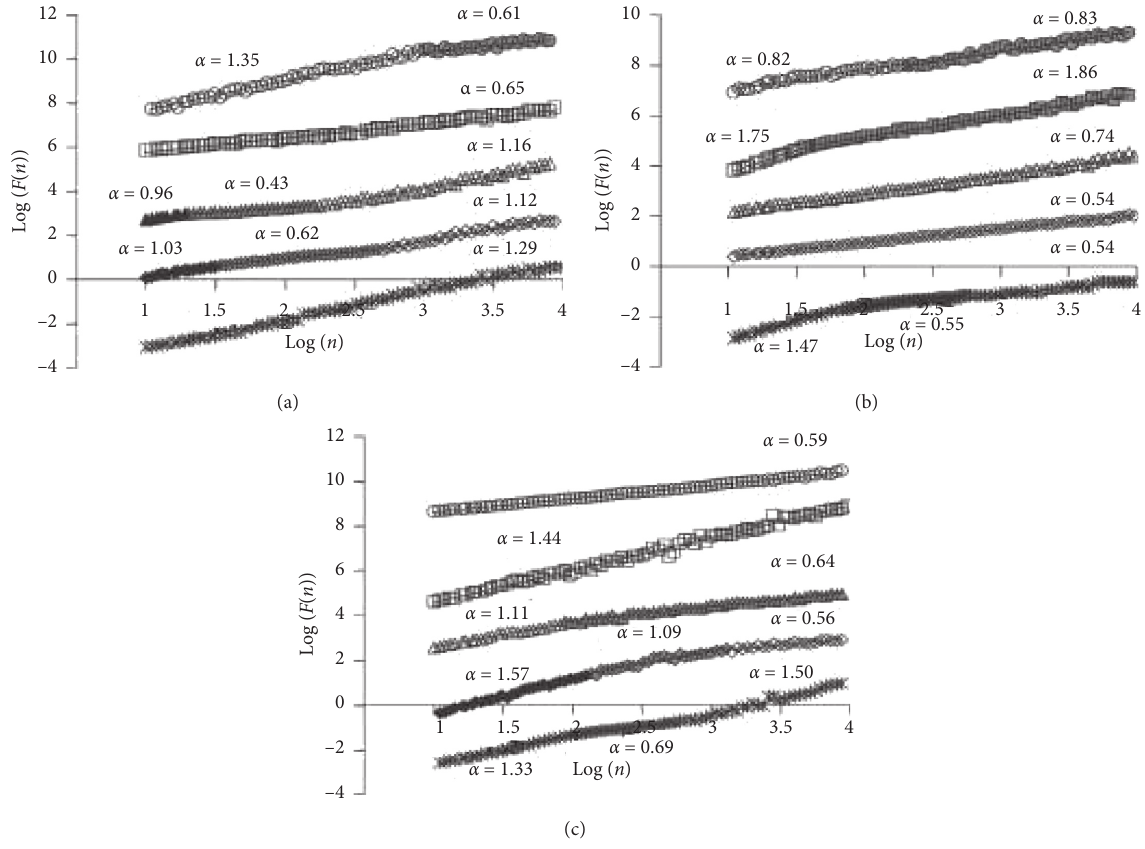
Figure 2: DFA p � 2, fluctuation curves of RTTtime series for first (a), second (b), and third (c) nights, night-time measurements. From top to bottom measurements for GTU, Harvard, UCLA, USC, and USTC